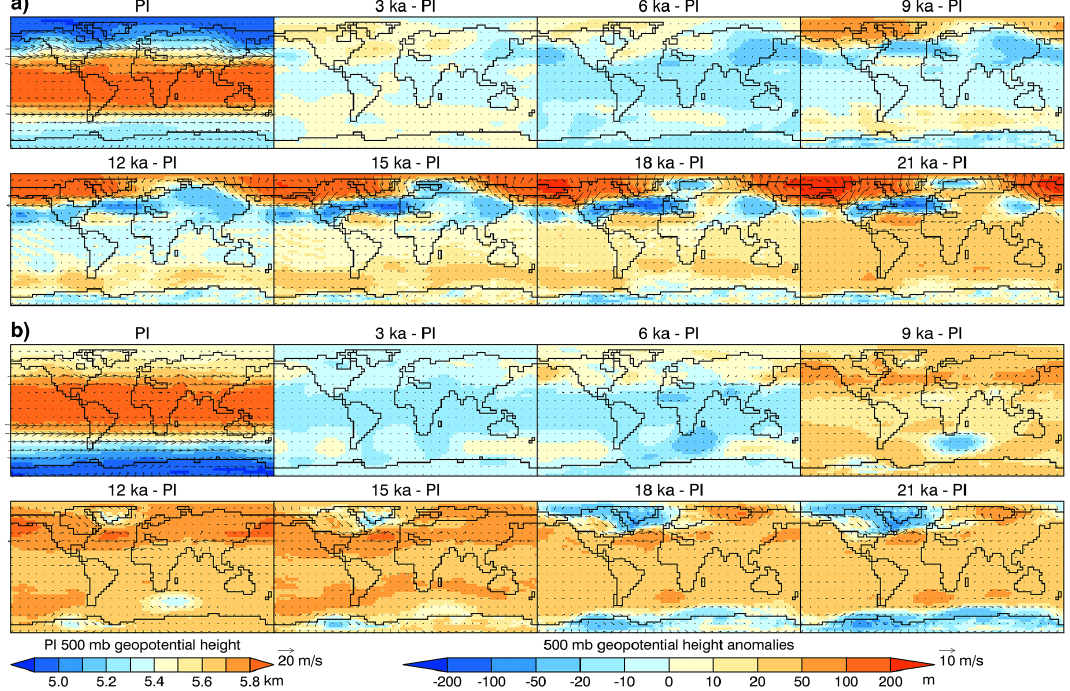
Figure 3. Simulated seasonal 500hPa geopotential height and wind anomalies relative to PI. (a) December, January, and February and (b) June, July, and August. Raw 500hPa geopotential height and wind are shown in Fig. S2 in the